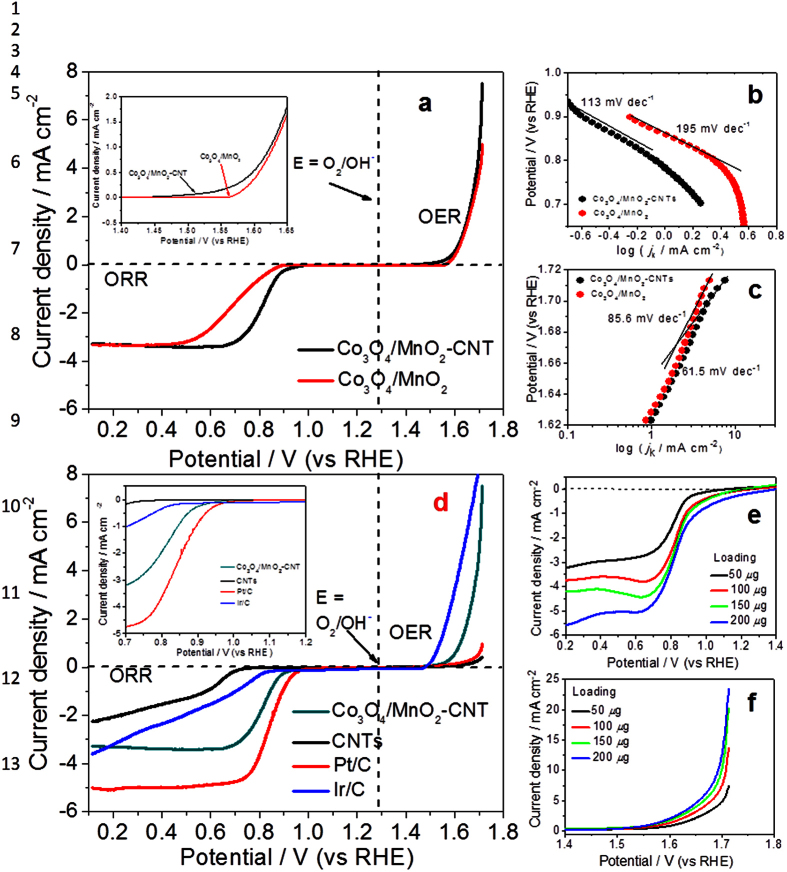
(a) ORR and OER polarization curves of Co3O4/MnO2and Co3O4/MnO2-CNTs (Insert: enlarged OER); (b) Tafel plots of ORR currents; (c) Tafel plots of OER currents; (d) ORR and OER polarization curves of Co3O4/MnO2-CNTs, 20%Pt/C, Ir/C and CNTs (Insert: enlarged ORR); (e) ORR polarization curves catalyzed by different loadings of Co3O4/MnO2-CNTs catalyst; (f) OER polarization curves catalyzed by different loadings of Co3O4/MnO2-CNTs catalyst.